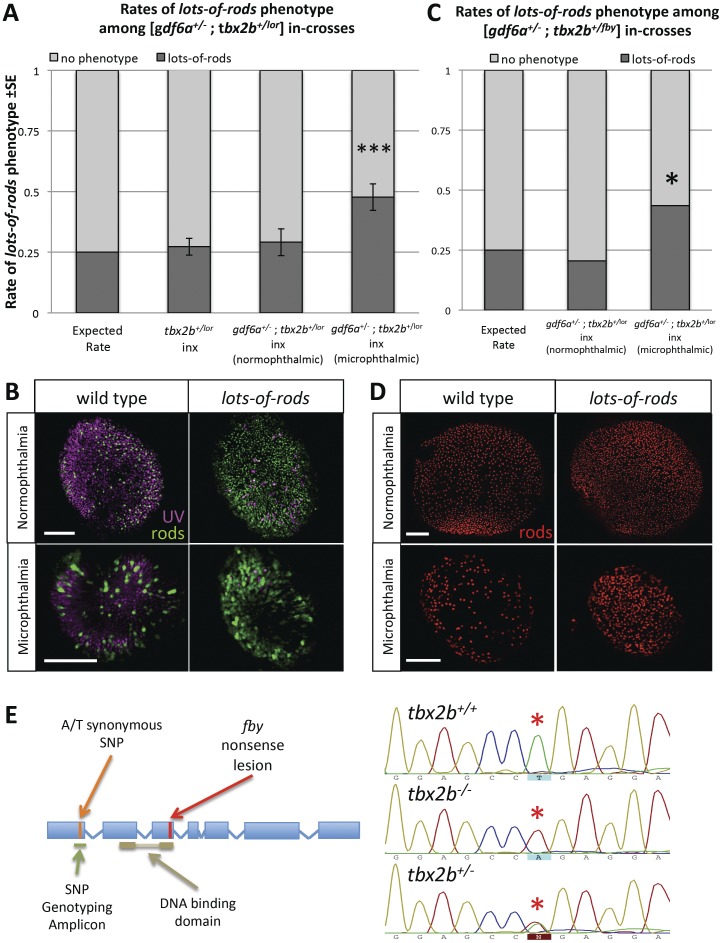

gdf6a modulates tbx2b regulation of UV cone and rod development.
A, B. When [gdf6a+/s327;tbx2b+/lor] compound heterozygous mutants are in-crossed (inx), a disproportionate fraction of microphthalmic offspring exhibit the lots-of-rods phenotype compared to normophthalmic siblings, tbx2b+/lo
r in-crosses, and to predicted Mendelian ratios of the recessive lots-of-rods phenotype (X
2 ***p<0.001; 3 replicates of n = 17, 19, 35 microphthalmics; 6dpf). UV cones and rods were labeled using antibodies 10C9.1 and 4C12 displayed in magenta and green, respectively. A portion of microphthalmic larvae with the lots-of-rods phenotype has a tbx2b+/lor genotype (see Table 1). C, D. When [gdf6a+/s327;tbx2b+/fby] compound heterozygous mutants are in- crossed, the lots-of-rods phenotype is again observed at higher rates in microphthlamic eyes compared to normophthalmic eyes (X
2 *p = 0.007; 1 replicate, n = 39 microphthalmics, 6 dpf). Panel D shows rod opsin in situ hybridization (red). Scale bars are all 50 μm. E. Genotyping for the lor mutation was performed via linkage analysis using an A/T synonymous SNP located before the DNA binding domain of tbx2b in lor and non-lor alleles, respectively. gdf6as327/s327 mutants with a corresponding SNP of T were used in crossing of the mutant lines.